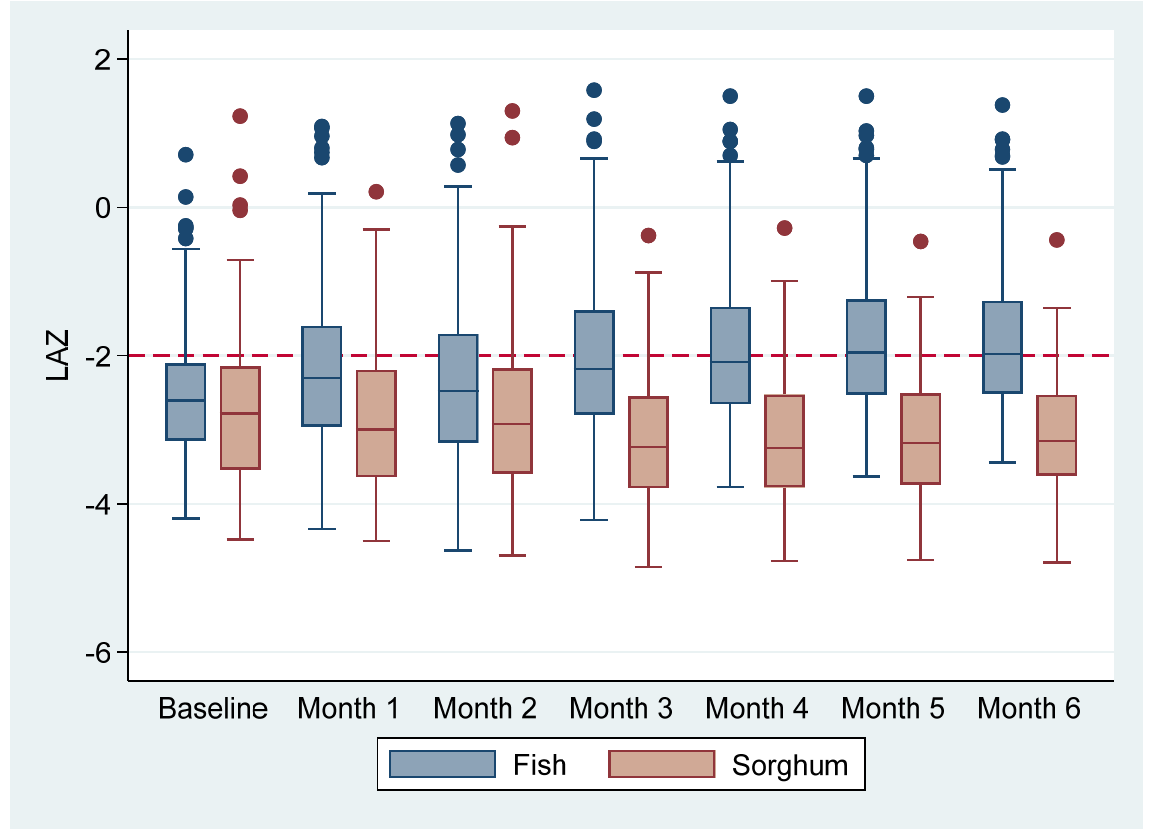
Figure 2. Boxplots of changes in length-for-age z-score (LAZ) over time between the fish powder group and sorghum powder group.